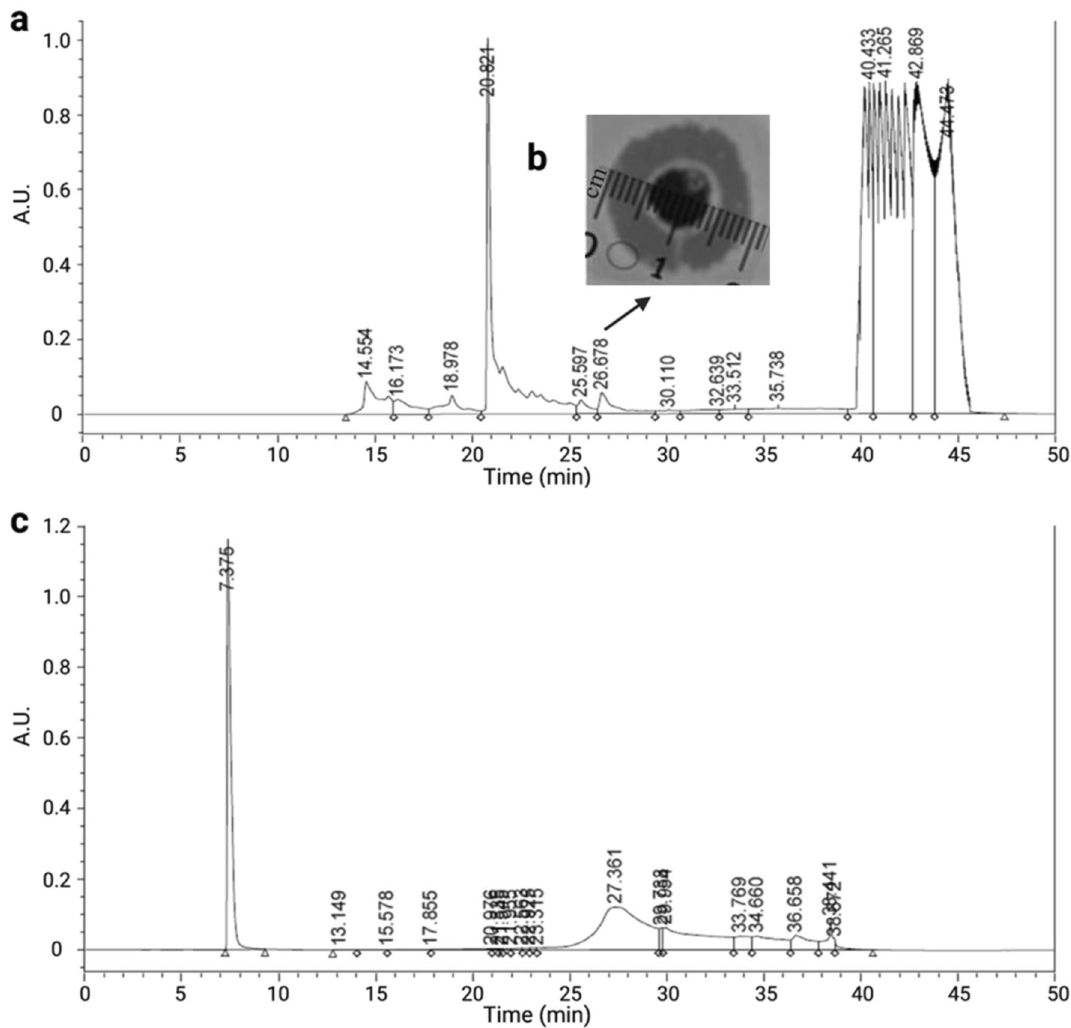
Figure 5. Purification of B. mori hemolymph infected with P.aeruginosa . ( a ) RP-HPLC fractionation of MGW extracted hemolymph through C-18 Semi-Prep column, ( b ) The arrow indicating the fraction exhibited antimicrobial activity (inhibition zone 1.9 cm), ( c ) RP-HPLC chromatogram of the active